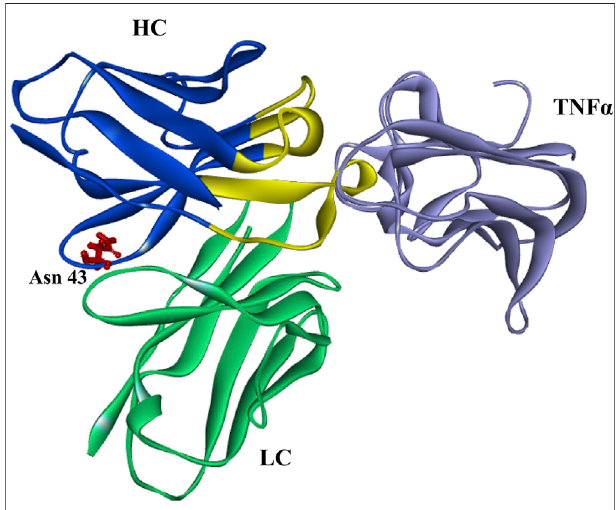
FIGURE 8 | Overall structure of the TNFa – golimumab complex (FRs: blue and CDRs: yellow) (Ono et al., 2018).